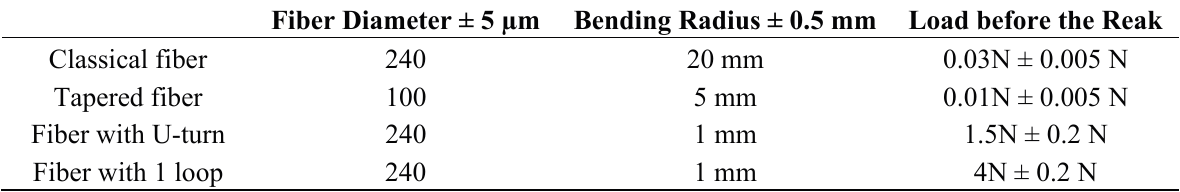
Table 1. Results of the 2-point bend tests for four different